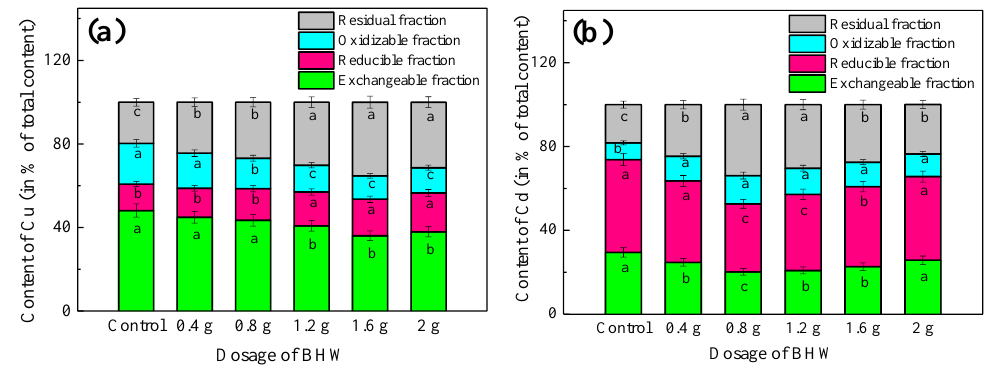
Figure 2. The effect of the amount of BHW material on the chemical fractions of copper ( a ) and cadmium ( b ) in the soil. Bars mean standard deviation and the data refer to means ± standard deviation (n = 3). Lowercase letters represent significant differences at p < 0.05 between different treatments at the same fraction.